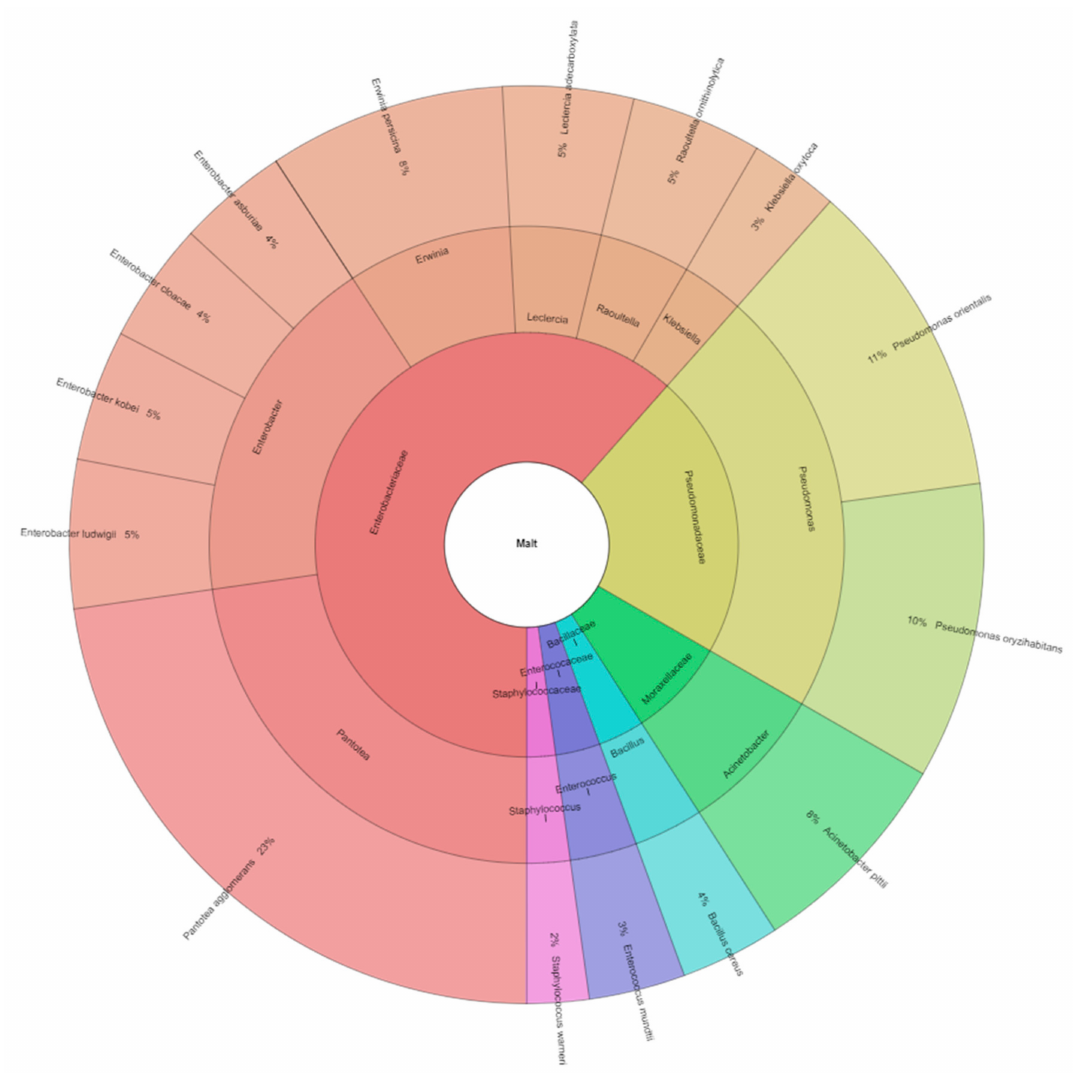
Figure 2. Krona of bacterial community isolated from